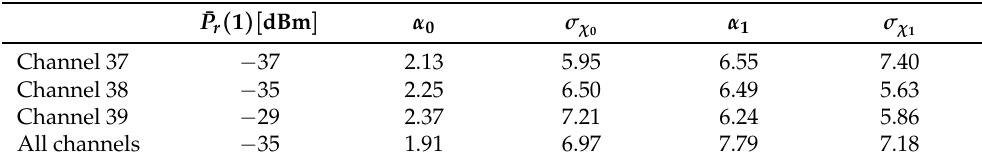
Table 1. Two-segment path loss model parameter values derived using one random data sample from only one